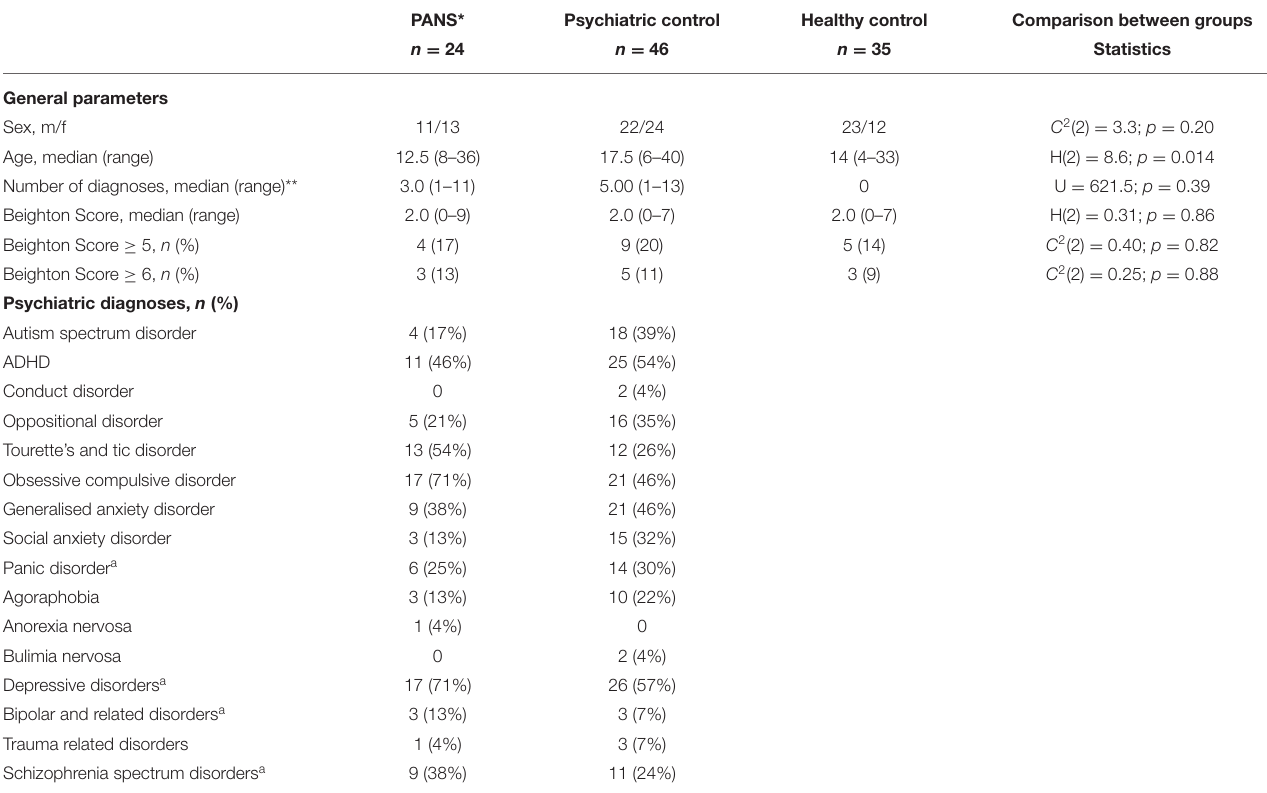
TABLE 1 | Demographics of participants at the time of the interview. PANS* Psychiatric control Healthy control Comparison between groups